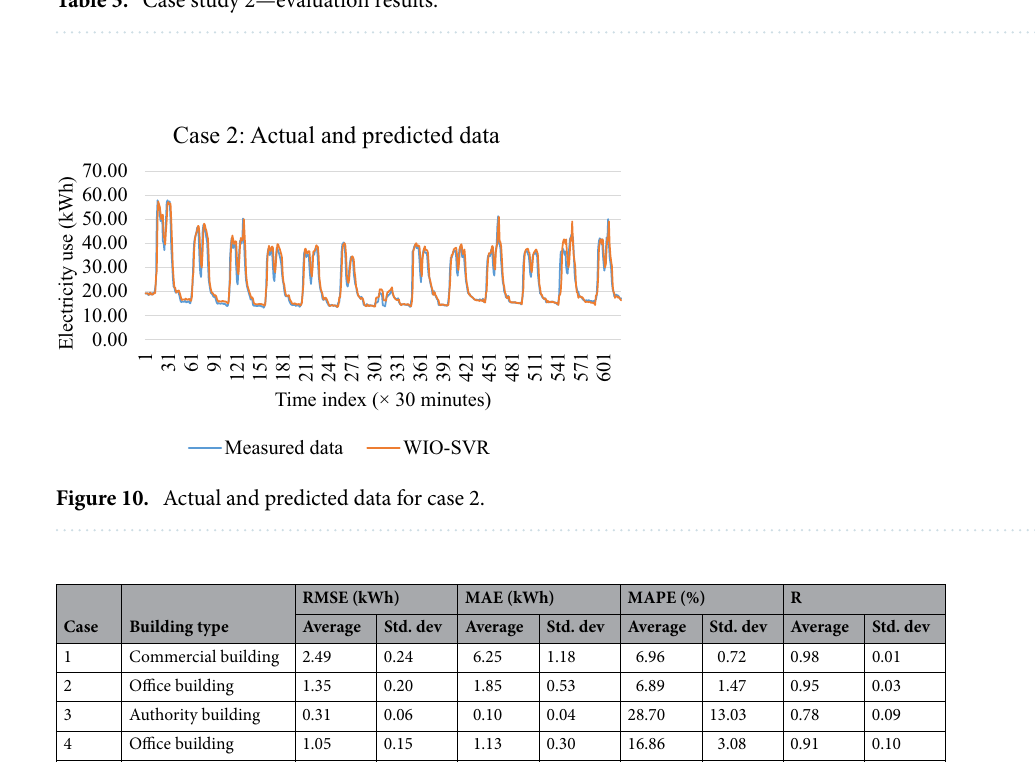
Table 3. Case study 2—evaluation results.